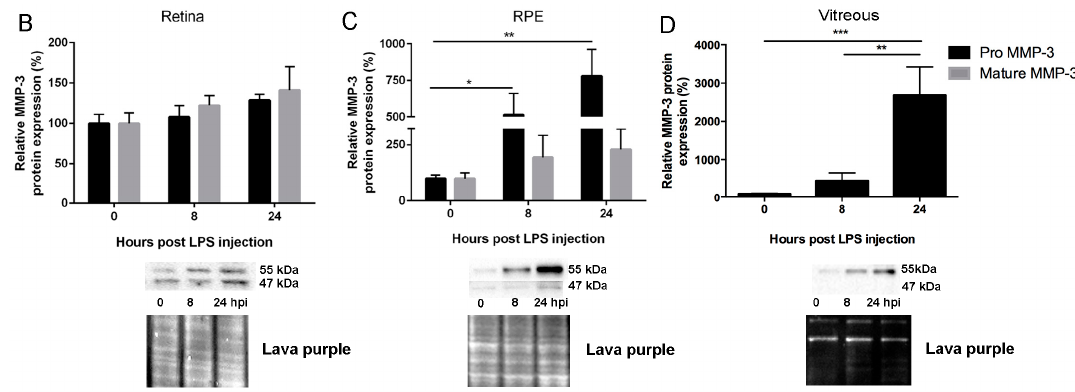
Figure 1. Matrix metalloproteinase-3 (MMP-3) mRNA and protein spatiotemporal expression pattern in the retina, retinal pigment epithelium (RPE) and vitreous of mice subjected to endotoxin-induced uveitis (EIU). ( A ) Real time-PCR analysis on retina and RPE samples from wild-type (WT) mice subjected to EIU revealed an apparent upregulation of Mmp3 levels in the RPE, reaching a peak around 16 hpi (hour post LPS injection), and returning to baseline levels at 24 hpi. Retinal samples demonstrated a similar upregulation in Mmp3 mRNA levels, although to a much lesser extent. RT-PCR data were normalized against the reference genes and were expressed as a percentage relative to 0 hpi; ( B , C ) Western blot data confirmed the PCR findings and showed a slight increase in pro- and mature MMP-3 levels in the retina, but a more pronounced upregulation of, in particular, pro MMP-3 protein in the RPE; ( D ) Western blot data revealed a significant increase of pro MMP-3 levels after 8 and 24 hpi in the vitreous cavity. Lava purple staining served as a loading control; ( E ) Representative images show localization of MMP-3 immunoreactivity (green) in the Müller glia in the retina of healthy WT mice. The blue staining represents DAPI nuclear counterstain. EIU increased expression of MMP-3 in these glial fibers, but also in the RPE. Scale bar: 100 µm. Western blot data were normalized against Lava purple total protein stain and expressed as a percentage relative to 0 hpi. All data are shown as mean ± SEM, n ≥ 5, * p ≤ 0.05, ** p ≤ 0.01, *** p ≤ 0.001, **** p ≤ 0.0001. NFL, nerve fiber layer; GCL, ganglion cell layer; IPL, inner plexiform layer; INL, inner nuclear layer; OPL, outer plexiform layer; ONL, outer nuclear layer; PL, photoreceptor layer; RPE, retinal pigment epithelium.